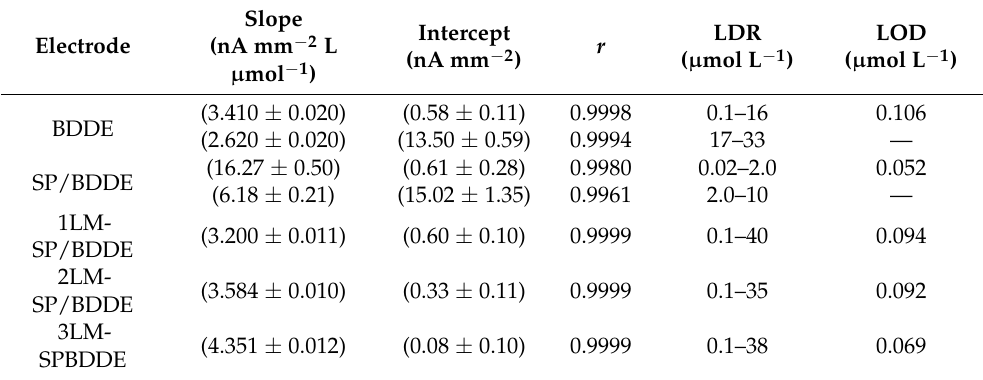
Table 6. Statistical parameters of voltammetric determination of lornoxicam (DPV, electrolyte—BRB